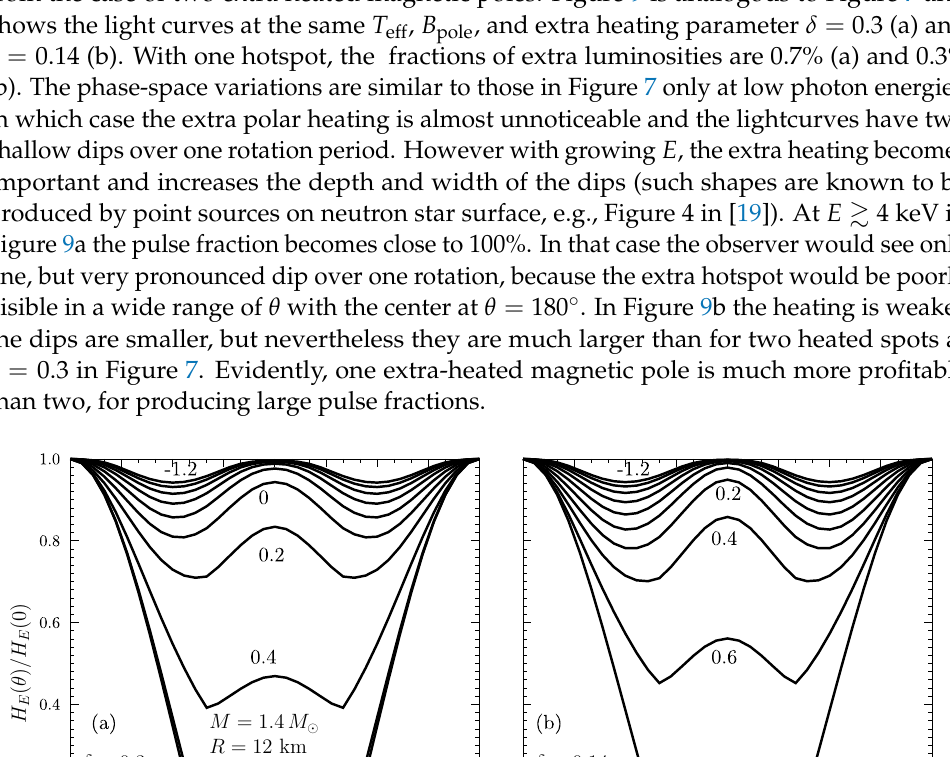
, R = 12 km, T eff = 1 MK and (cid:12)